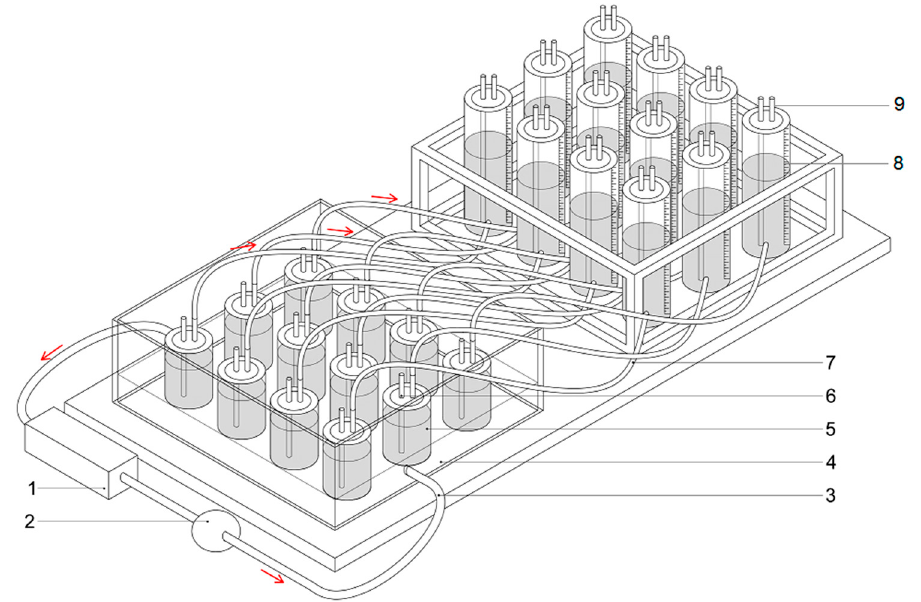
Figure 1. Biofermenter for biogas production tests (18-chamber section): 1—water heater with temperature adjustment; 2—water pump; 3—insulated tubes for liquid heating medium; 4—water jacket (39 °C); 5—biofermenter (1.4 dm 3 ); 6—slurry-sample drawing tube; 7—tube for transporting the biogas; 8—graduated tank for biogas; 9—gas sampling valve.